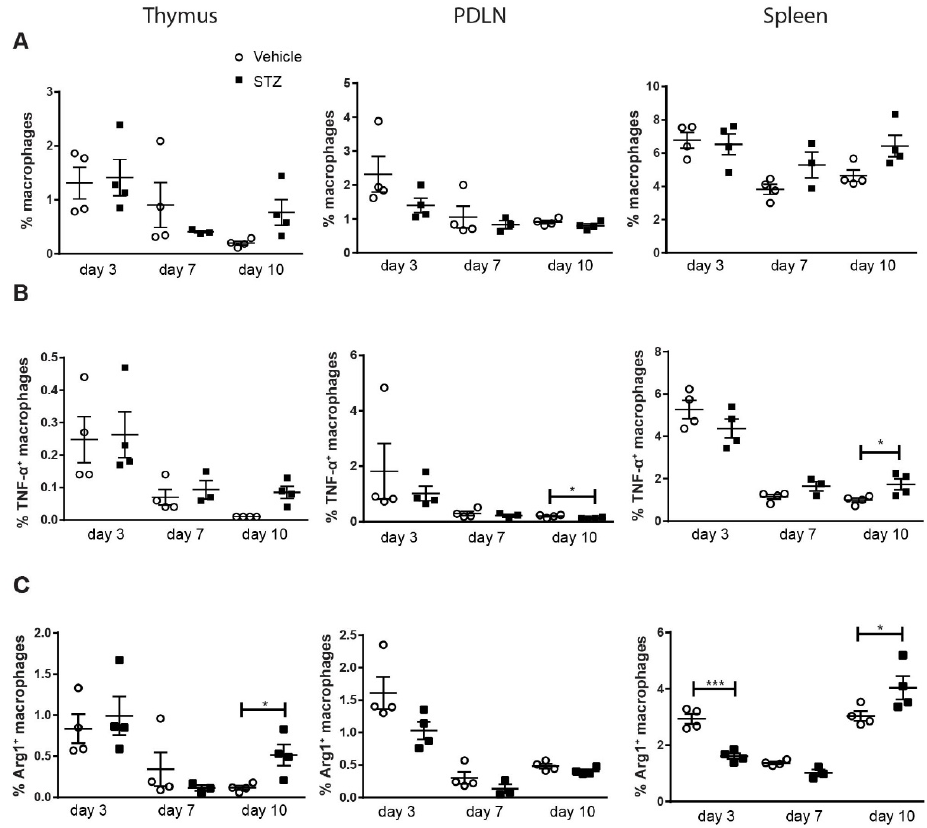
Figure 1. The kinetics of macrophage polarization. Male CD ‐ 1 mice were injected intraperitoneally with saline or low dose STZ (40 mg/kg body weight) for 5 consecutive days. Single cells were pre ‐ pared from thymi, PDLNs and spleens. ( A ) The proportions of macrophages. ( B ) The proportions of TNF ‐α + macrophages. ( C ) The proportions of Arg1 + macrophages. Results are expressed as means ± SEM. Unpaired t ‐ tests were performed for comparisons. * and *** denote p < 0.05 and p < 0.001.